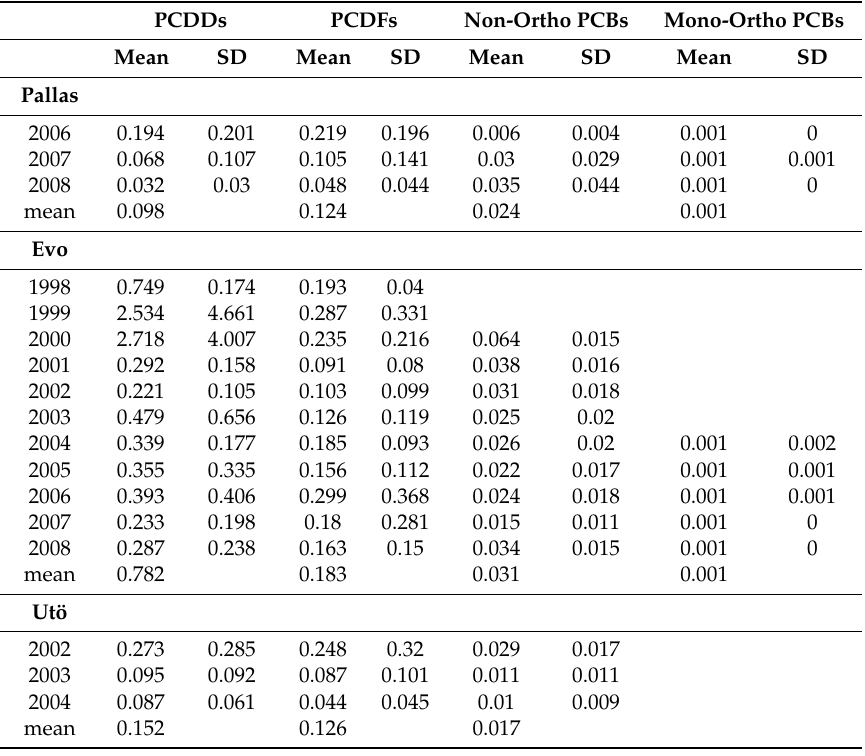
Table 3. Bulk deposition in different years (mean, SD = standard deviation) of PCDDs, PCDFs, non-ortho PCBs and mono-ortho PCBs WHO-TEQ pg/m 2 /day in Pallas, Evo, and